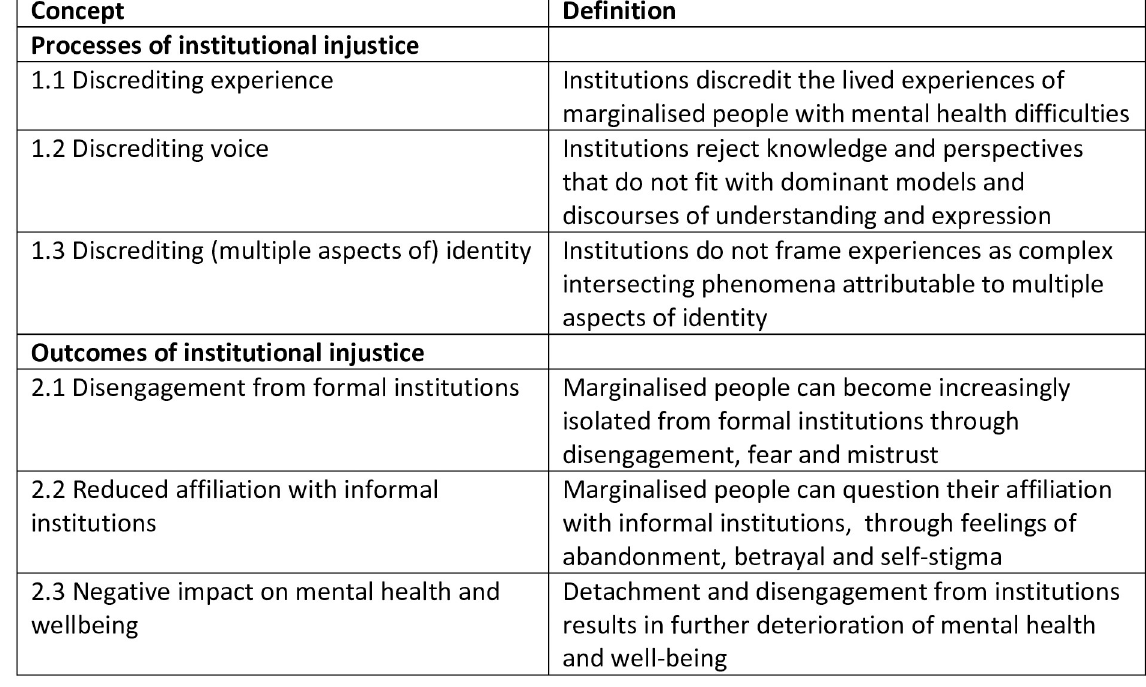
Fig 1. Sensitising concepts on institutional